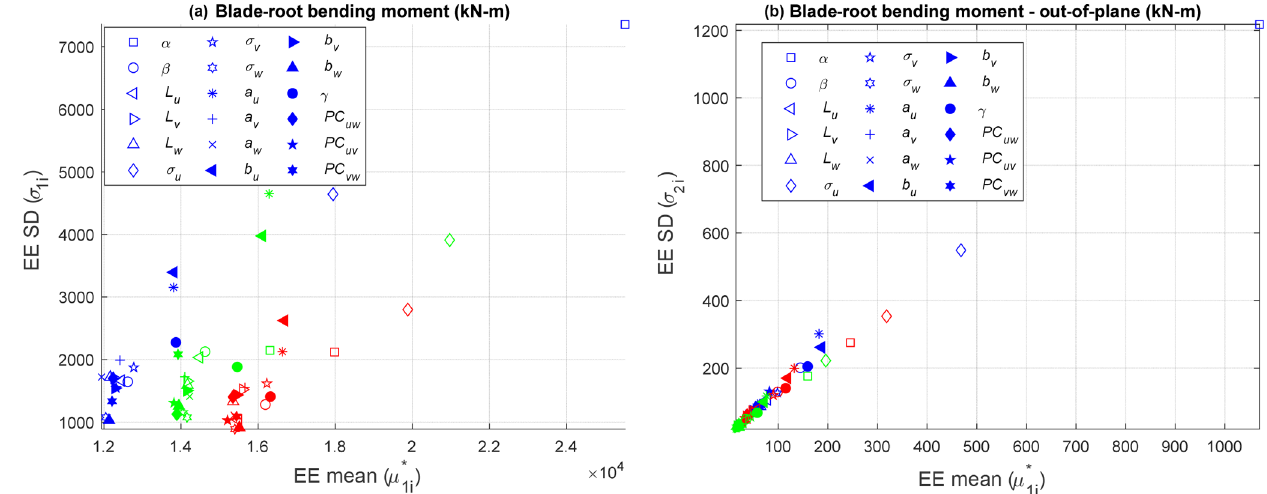
Figure A1. EE standard deviation versus EE mean for blade-root bending moment ultimate load (a) and blade-root Oop bending moment fatigue load (b) at all wind speed bins (blue is below-rated speed, red is near-rated speed, green is above-rated speed).